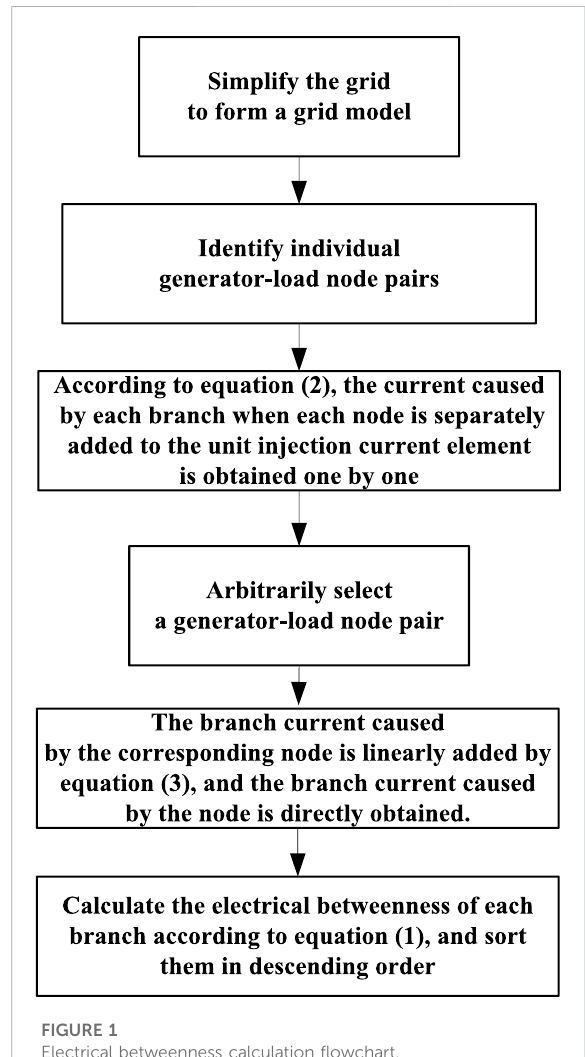
FIGURE 1 Electrical betweenness calculation fl